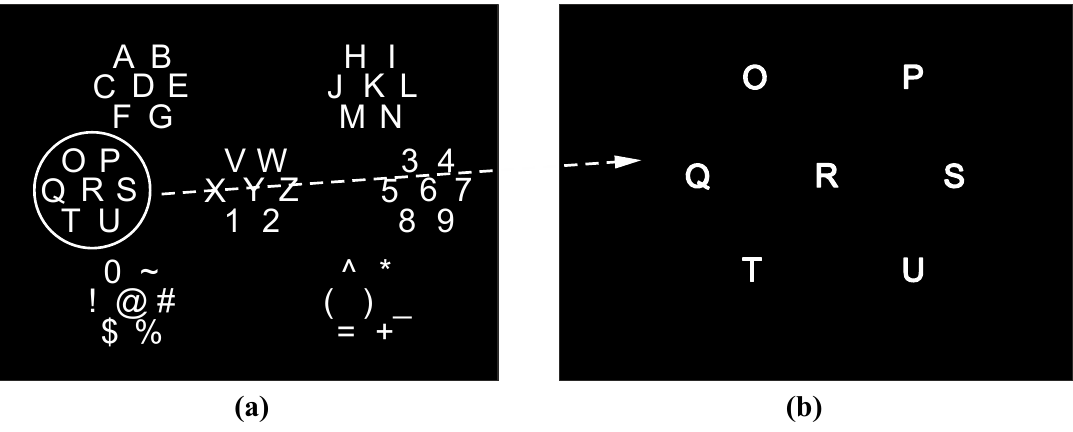
Figure 9. The proposed region-based paradigm for the improved P300 speller: ( a ) The first level of intensification where each group contains up to seven characters; and ( b ) One region is expanded at the second level (adapted from